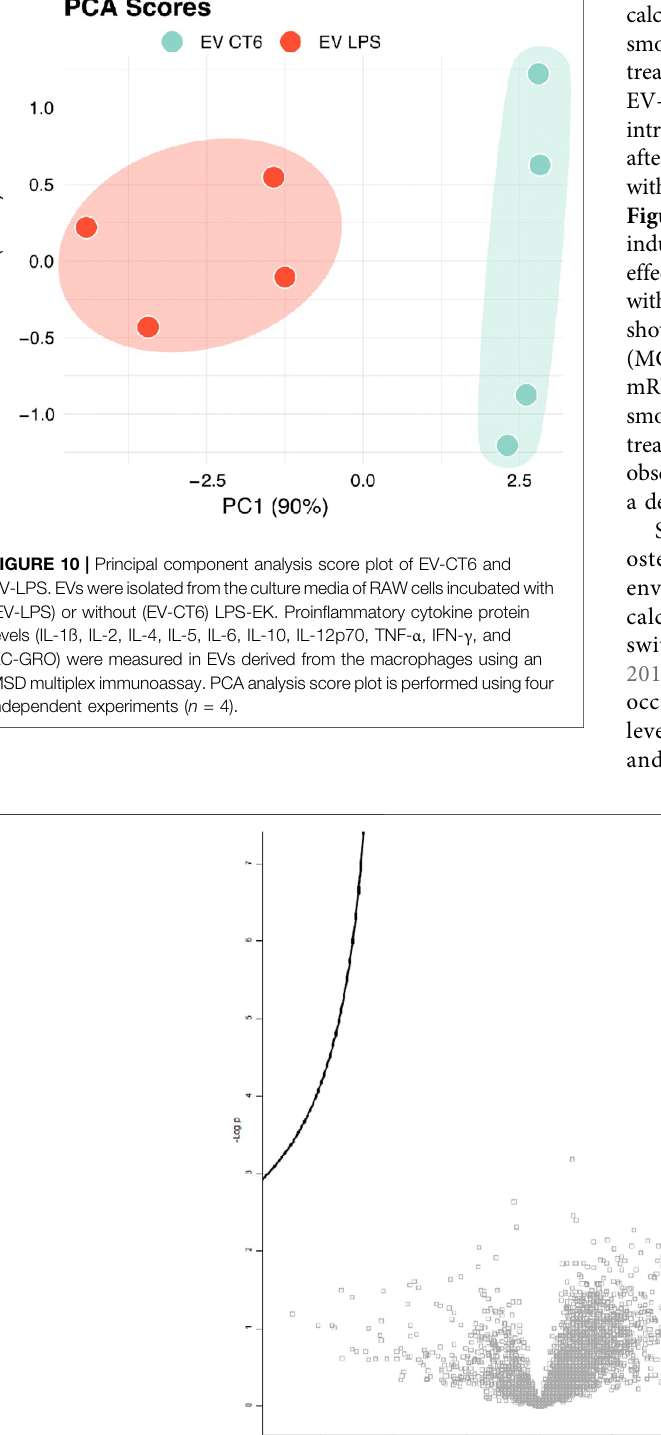
Frontiers in Cell and Developmental Biology |